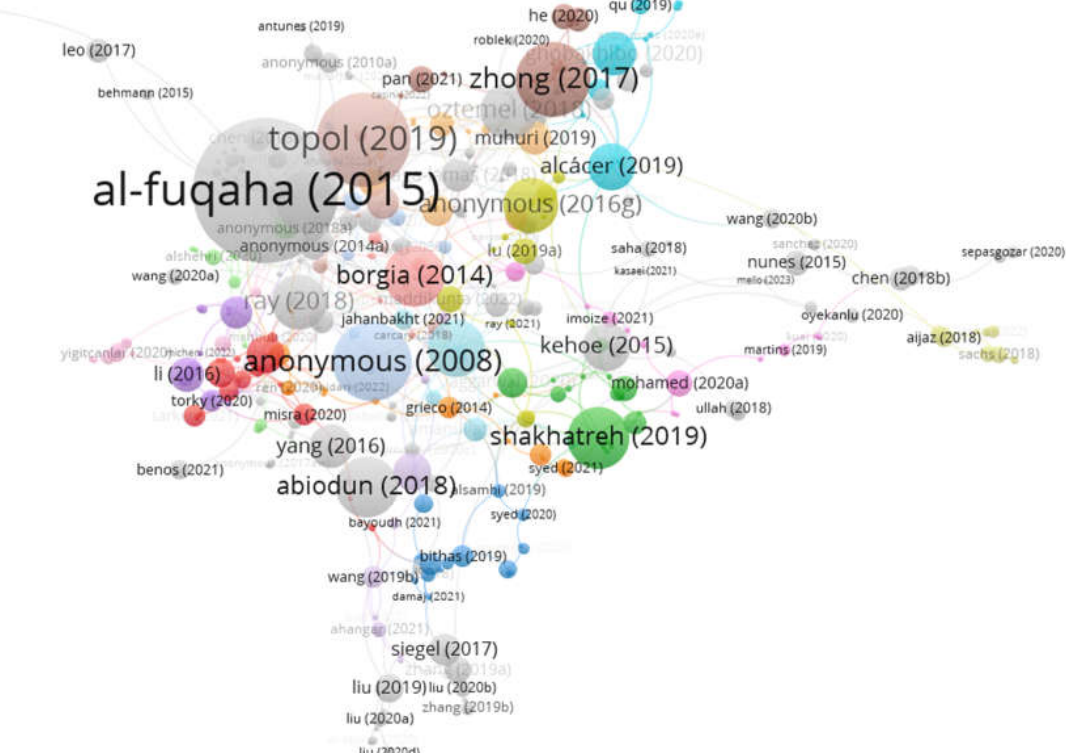
Figure 2. VOSviewer mapping of remote big data management tools, sensing and computing technologies, and visual perception and environment mapping algorithms in the Internet of Robotic Things regarding citation.